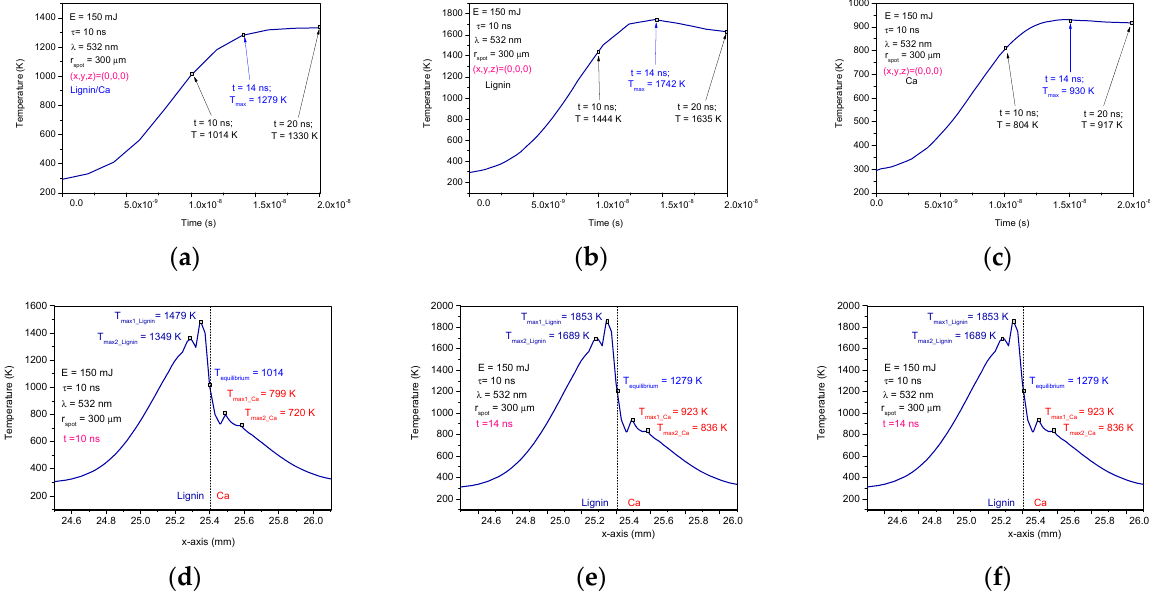
Figure 6. Pulsed laser heating effects on the lignin/Ca composite: Temperature diagrams in time on the spot center of the lignin/Ca composite target ( a ), of the calcium target ( b ) and of the lignin target ( c ); in pulse width on the lignin/Ca composite target (10 ns) ( d ), 14 ns after pulse laser ignition on the lignin/Ca composite target ( e ) and 20 ns after pulse laser ignition on the lignin/Ca composite target ( f ).